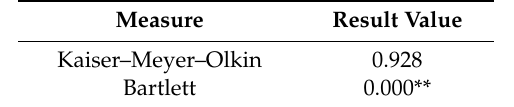
Table 5. Appropriateness selection of Co-Wis subtest and suitability of factor analysis model.